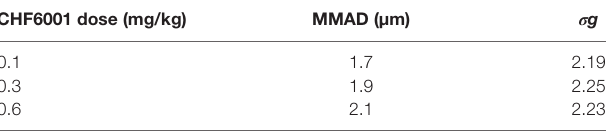
TABLE 2 | Mass median aerodynamic diameter (MMAD, µm) of